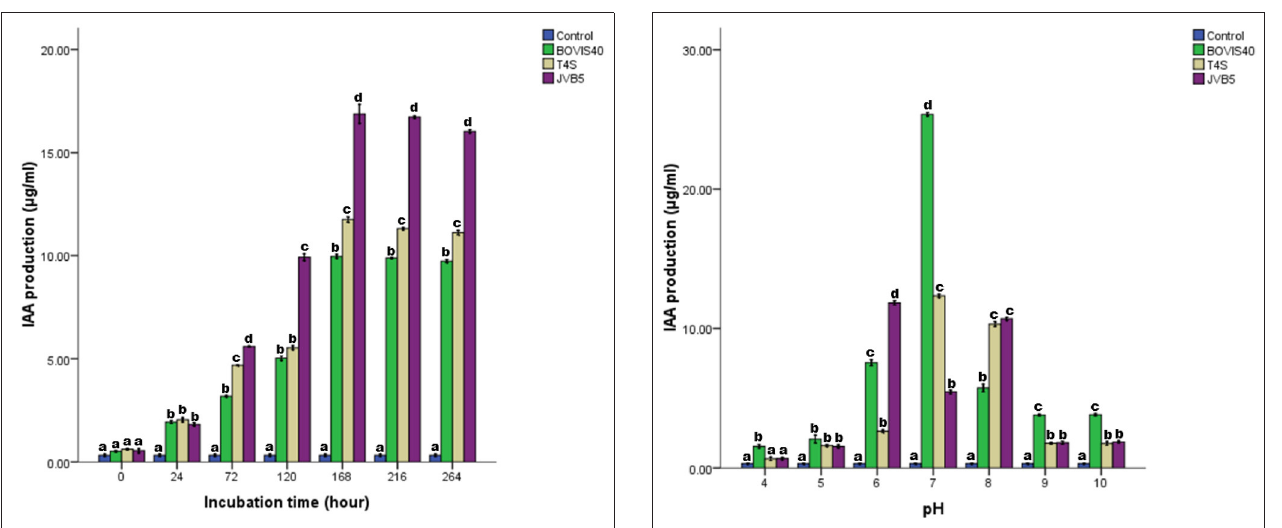
FIGURE 6 | Effect of pH on IAA production by endophytic bacteria. The different alphabets indicate significant differences in triplicate readings. IAA production by B. amyloliquefaciens FZB42 in a